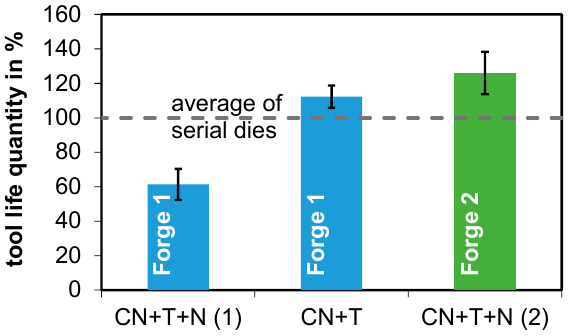
Figure 11. Tool life quantities of the carbonitrided and tempered (and nitrided) dies.